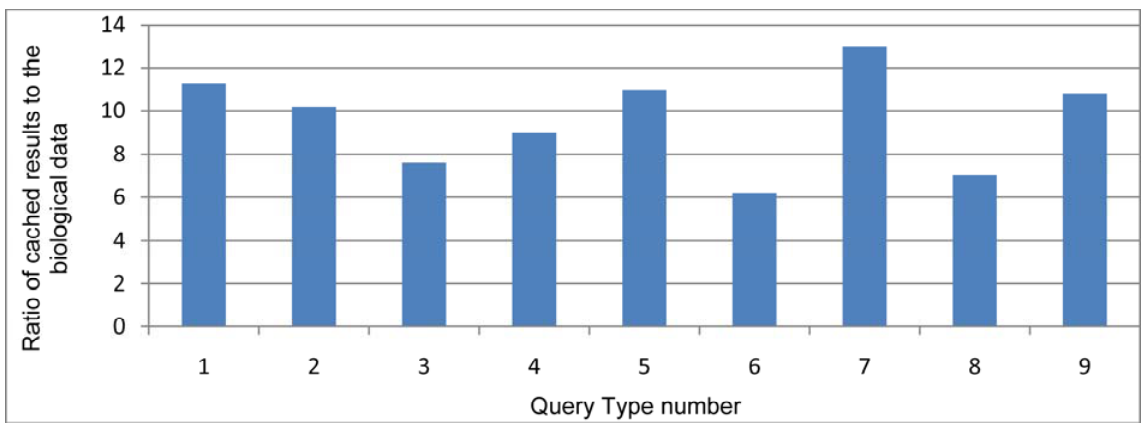
Fig. 10: Average cached hash table size as a percentage of the biological